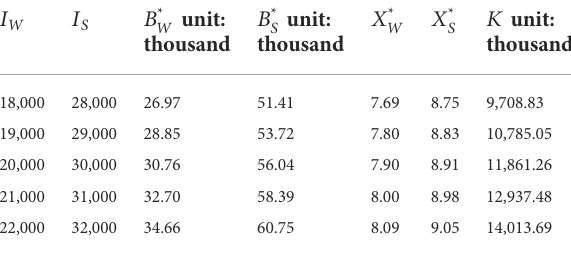
TABLE 5 The in fl uence of the I i , i (cid:2) W , S of shift variable on B * W , B * S , X